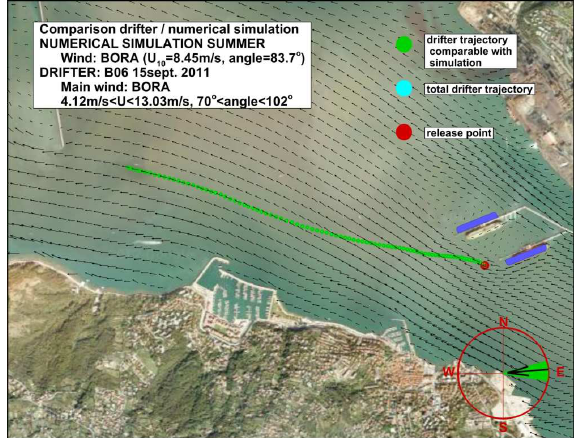
Fig. 12. Qualitative comparison of the numerical flow field, black vectors, with respect to the drifter trajectory, green dots, for the Ponente scenario.